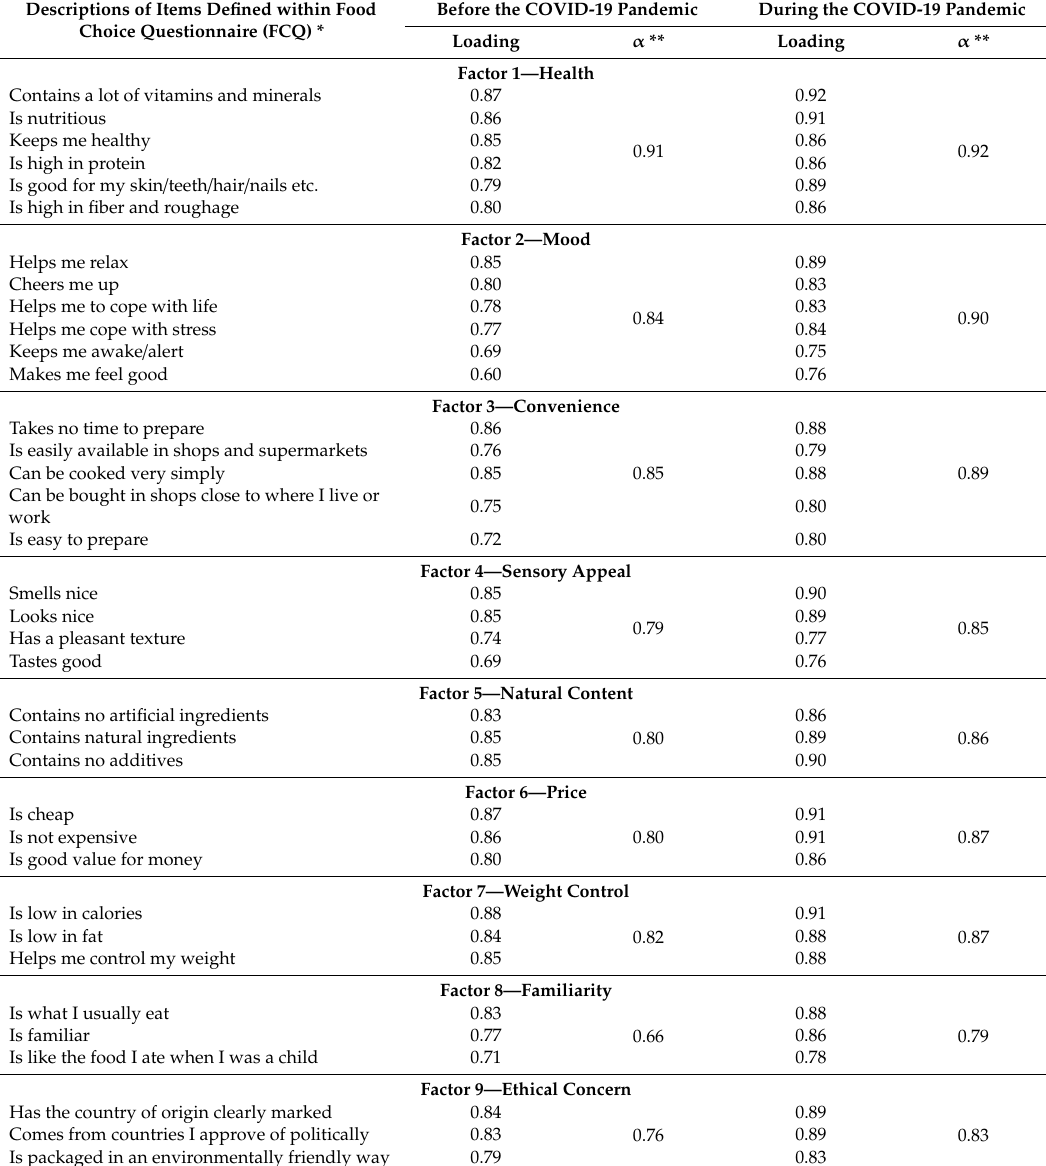
Table 3. The results of the loading and Cronbach’s alpha coe ffi cient for the applied Food Choice Questionnaire (FCQ) for the period before and during the COVID-19 pandemic for the sample of female adolescents studied within the PLACE-19 Study ( n =